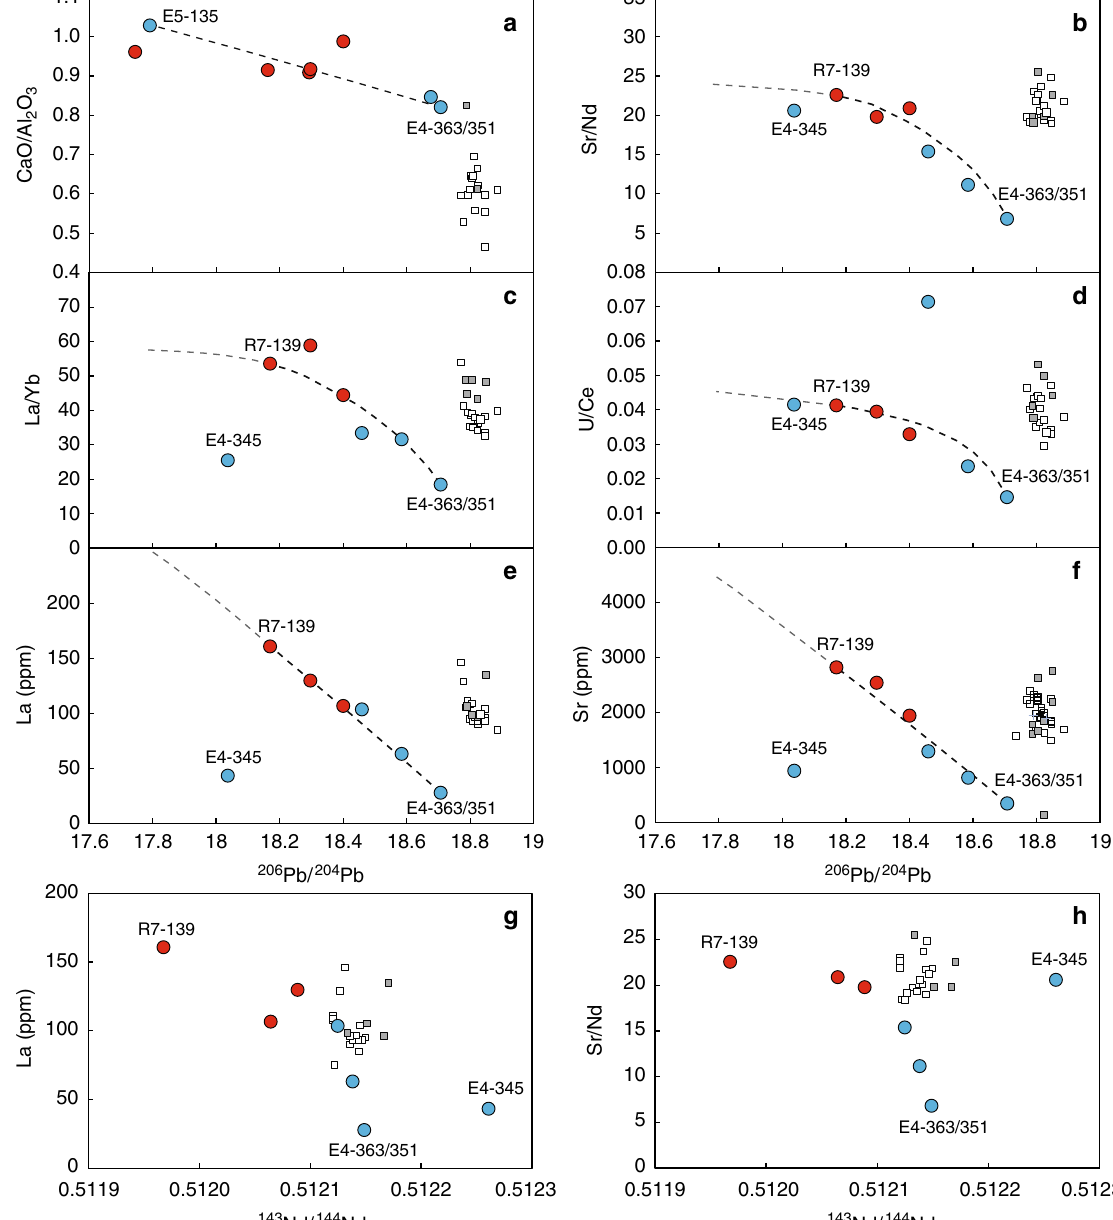
Fig. 4 Relations between 206 Pb/ 204 Pb or 143 Nd/ 144 Nd and major and trace-element contents and ratios for MIs compared to Roccamon fi na Ernici bulk rock lavas. The upper six panels a – f show CaO/Al 2 O 3 , Sr/Nd, La/Yb, U/Ce, La (ppm) and Sr (ppm) versus 206 Pb/ 204 Pb; the lower two panels g , h show La (ppm) and Sr/Nd versus 143 Nd/ 144 Nd. Grey and white square symbols represent bulk rock data from Roccamon fi na and Ernici, respectively 76 . Red and blue circles are melt inclusion data for Roccamon fi na and Ernici from this study. Negative relations exist between Pb isotopes and the element concentrations and ratios, suggesting mixing between a source with similar to but more trace element depleted compositions than the host lavas, and a source with unradiogenic Pb and highly enriched trace-element contents. Dashed lines represent binary mixing between the melt inclusion with most radiogenic 206 Pb/ 204 Pb (E4 – 363 – 351) and the inclusion along the trend with most unradiogenic 206 Pb/ 204 Pb (E5 – 135 or R7 – 139, ignoring the outlier E4 – 345). The lines are extended towards the potential exotic endmember with more unradiogenic Pb (grey dashed line). Source data are provided as a Source Data fi